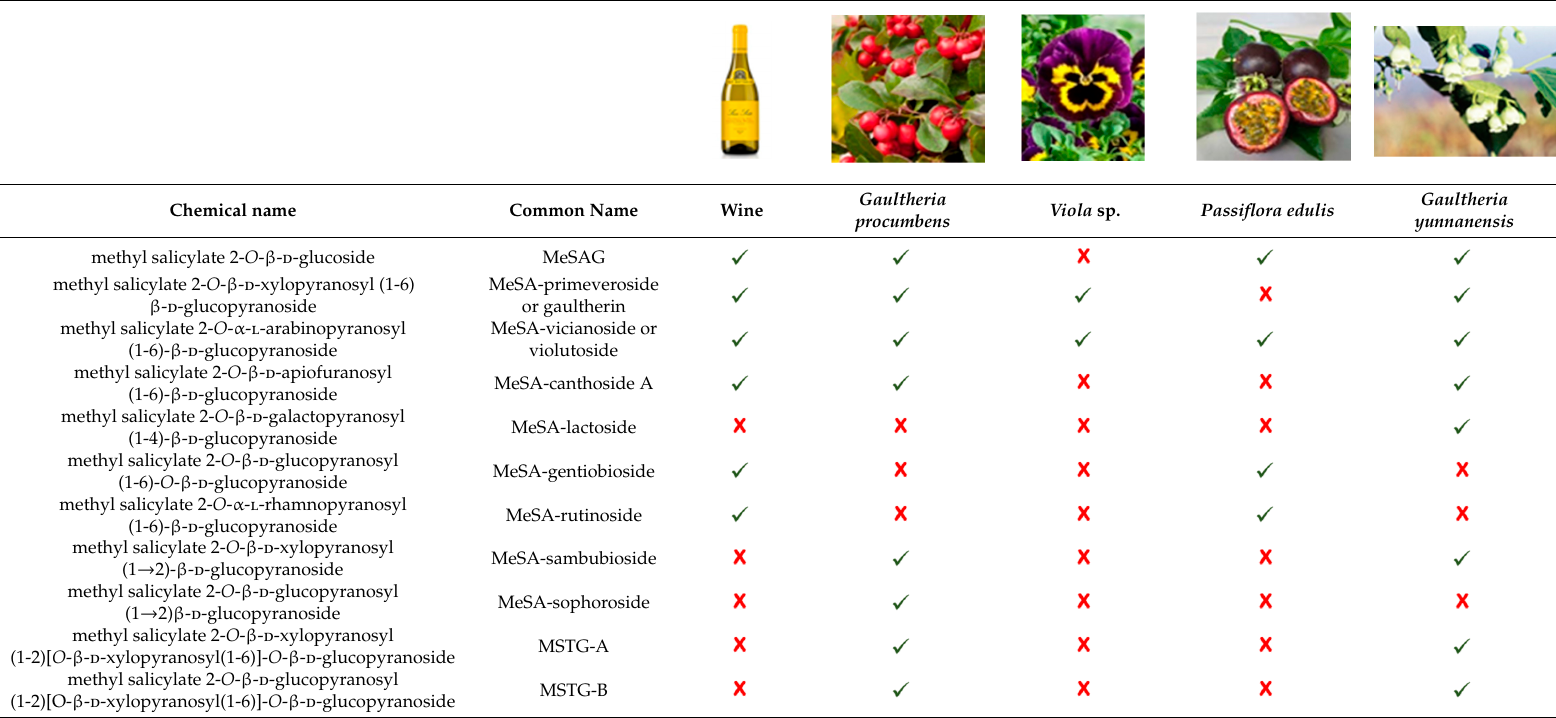
Chemical name Wine